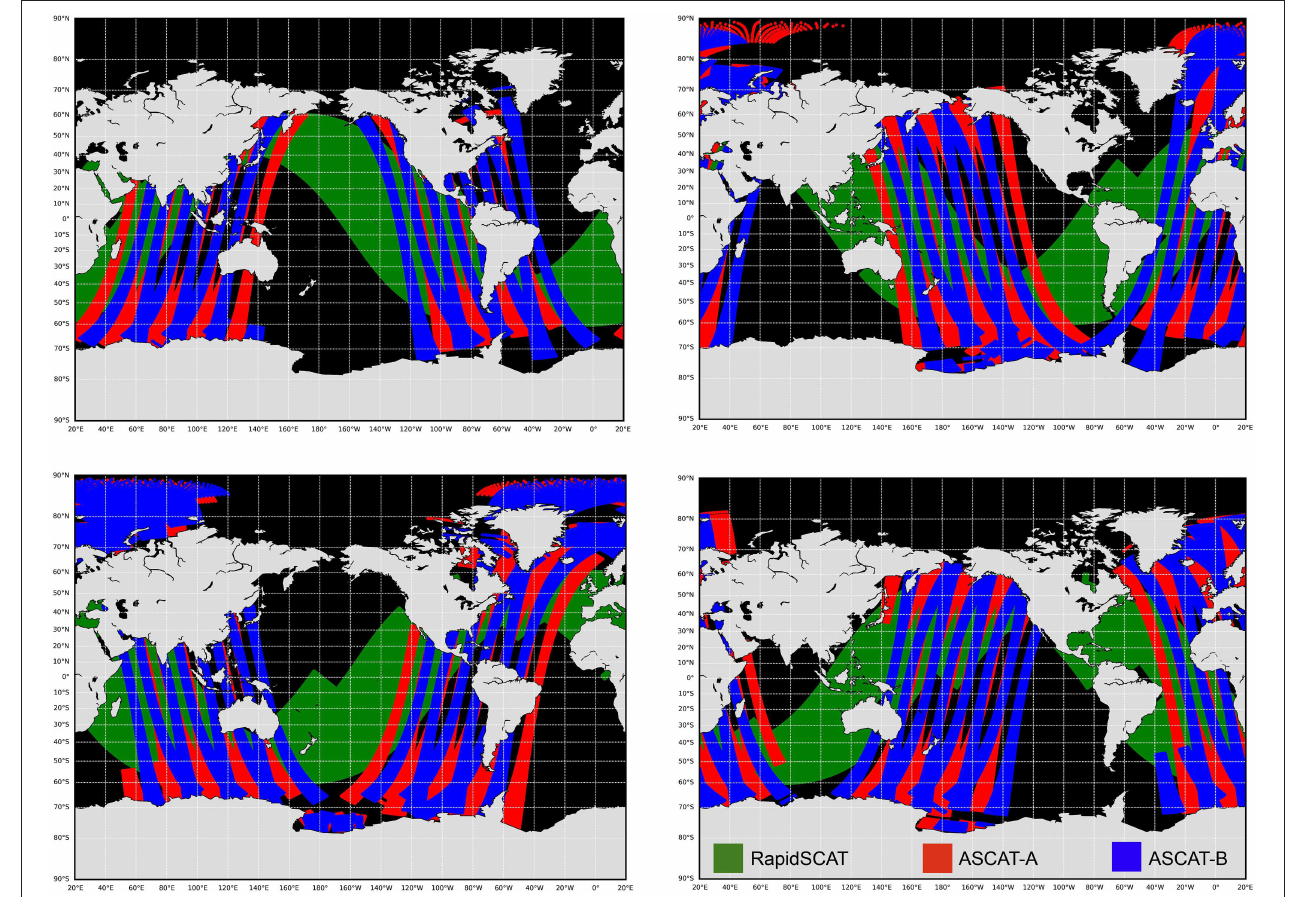
FIGURE 3 | Examples of coverage from 0 to 6Z (upper left), 6 to 12Z (upper right), 12 to 18Z (lower left), and 18 to 24Z (lower right) based on one equatorial orbiting instrument (RapidSCAT; green) and two instruments (ASCAT-A in red and ASCAT-B in blue) in sun synchronous orbits. While this configuration has considerable advantages for intercalibration and studies of convection, and has the World Meteorological Organization recommended number of satellites, the temporal sampling is clearly